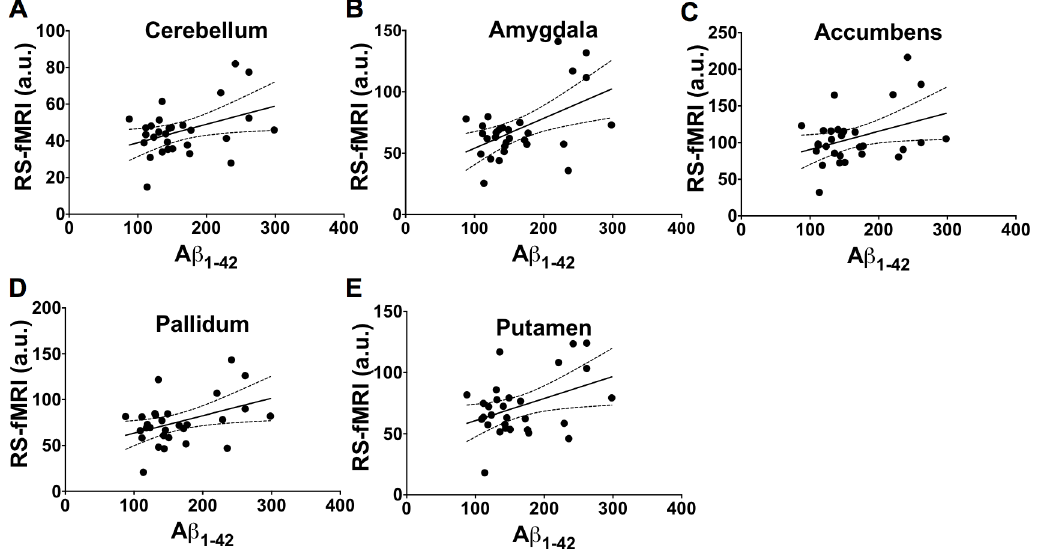
Fig 8. Relationship between mean brain activity measuredusing RS-fMRI and CSF derived Amyloid Beta 1-42 . The 95% confidenceintervalsfor the regressionsare shown as dotted lines. Associationbetweenthe brain activity and A β 1–42 in the cerebellum(r = 0.40, p = 0.03, A), amygdala(r = 0.51, p = 0.004, B), accumbens(r = 0.37, p = 0.04, C), pallidum(r = 0.41, p = 0.02, D), and putamen(r = 0.41, p = 0.02, E). These correlationswere not significantfollowing Bonferroni correction for multiple